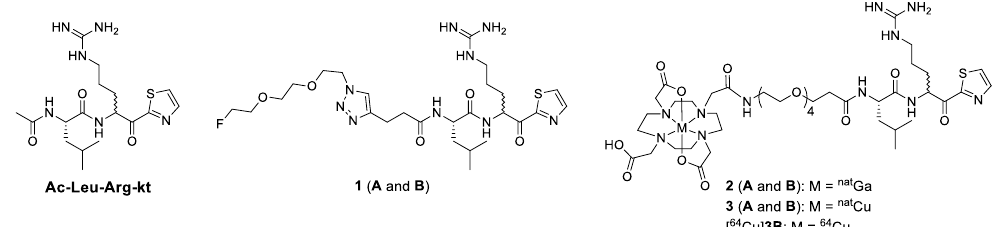
Figure 1. Structures of Ac – Leu – Arg – kt, ligands 1 – 3 , and [ 64 Cu] 3B